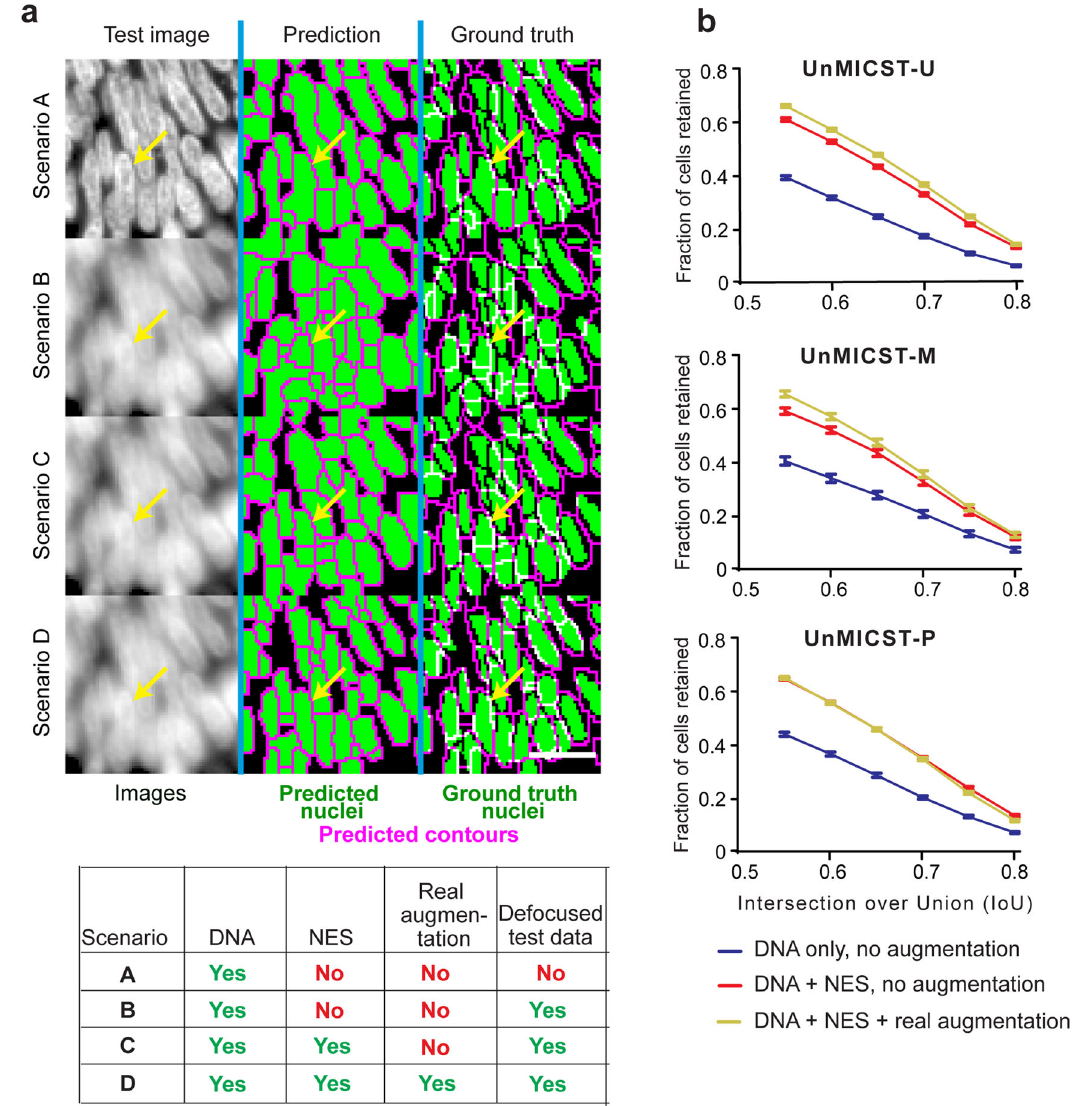
Fig. 4 Combination of NES and real image augmentations on segmentation performance. NES - nuclear envelope staining. a Models trained with in-focus DNA data alone produced probability maps that were undersegmented, especially in densely-packed tissue such as small intestine (Scenario A). When tested on defocused data, nuclei borders were largely incorrect (Scenario B). Adding NES restored nuclei border shapes (Scenario C). Combining NES and real augmentations reduced false positive detections and produced nuclei masks better resembling the ground truth labels (Scenario D). Scalebar denotes 20 μ m. Table legend shows conditions used for each scenarios A – D. Yellow arrow indicates a blurry cell of interest where accuracy improves with NES and real augmentation. b Graphs compare the accuracy represented as the number of cells retained across varying IoU thresholds with all models from UnMICST-U (top), UnMICST-M (center), and UnMICST-P (bottom). In all models, more nuclei were retained when NES and real augmentations were used together during training (yellow curves) compared to using NES without real augmentations (red curves) or DNA alone (blue curves). Error bars are standard error of learning frameworks, including NES data and real augmentations analysis described above using three scenarios for training and increased the fraction of nuclei retained by 50% at an IoU testing with both in-focus (Fig. 5a) and defocused images threshold of 0.6 (Fig. 4b). The accuracy of UnMICST-P (blue (Fig. 5b). Scenario 1 used in-focus DNA images for training (blue curve) trained on in-focus DNA data alone was higher than the bars), scenario 2 used in-focus DNA and NES images (red bars), other two baseline models at all IoU thresholds, suggesting that and scenario 3 used in-focus DNA and NES images plus real UnMICST-P has a greater capacity to learn. UnMICST-P may augmentation (green bars). While the magnitude of the have an advantage in experiments in which staining the nuclear improvement varied with tissue type and test set (panel a vs b), envelope proves dif fi cult or impossible. the results as a whole support the conclusion that including both NES and real augmentations during model training confers sta- tistically signi fi cant improvement in segmentation accuracy with multiple tissue types and models. The accuracy boost was greatest when models performed poorly (e.g., in scenario 1 where models multiple tissue types . To determine if improvements in seg- were tested on defocused colon image data; Fig. 5b, blue bars), so mentation would extend to multiple tissue types we repeated the